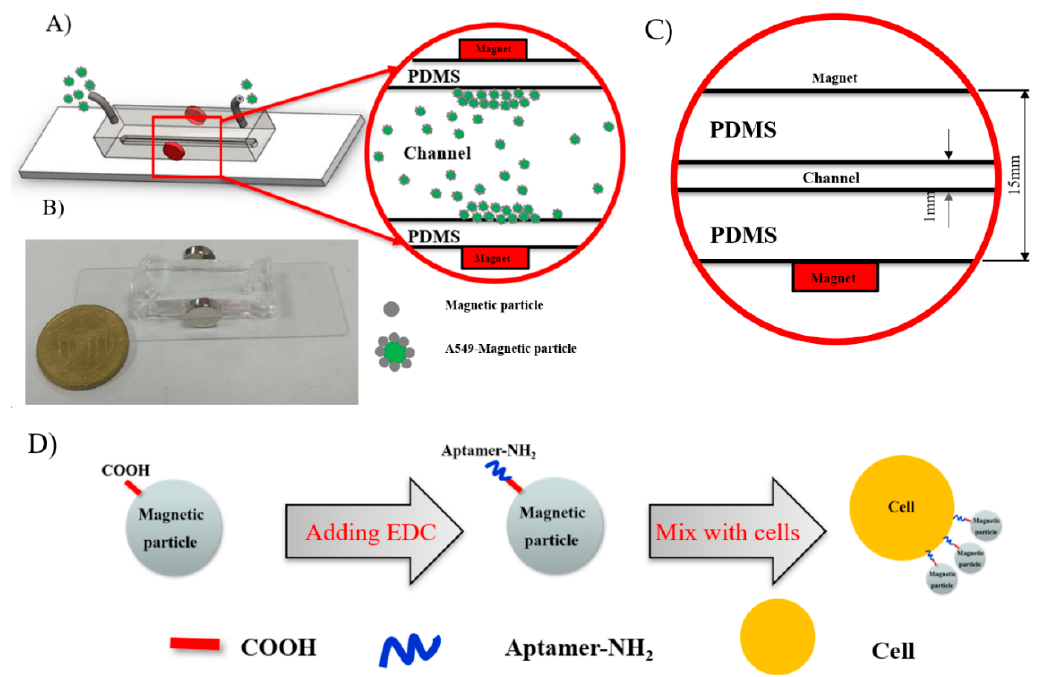
Figure 1. ( A ) Schematic diagram of the proposed chip structure; ( B ) photograph of the proposed chip; ( C ) dimensions of the microchip; ( D ) illustration of the immunomagnetic beads labeling procedure to A549 cells.